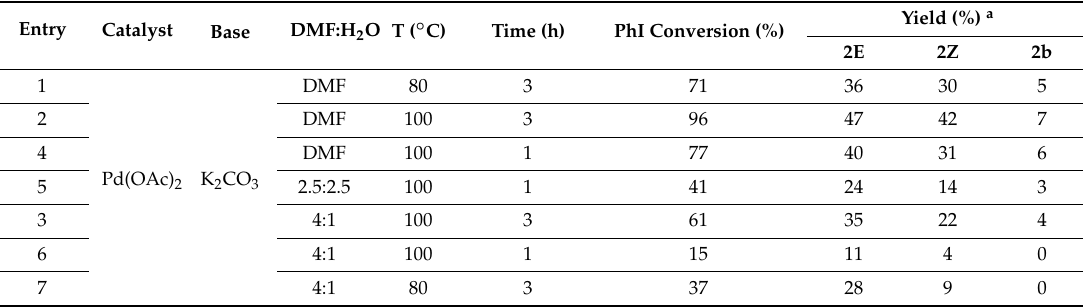
Table 2. Results of the Heck arylation of estragole with